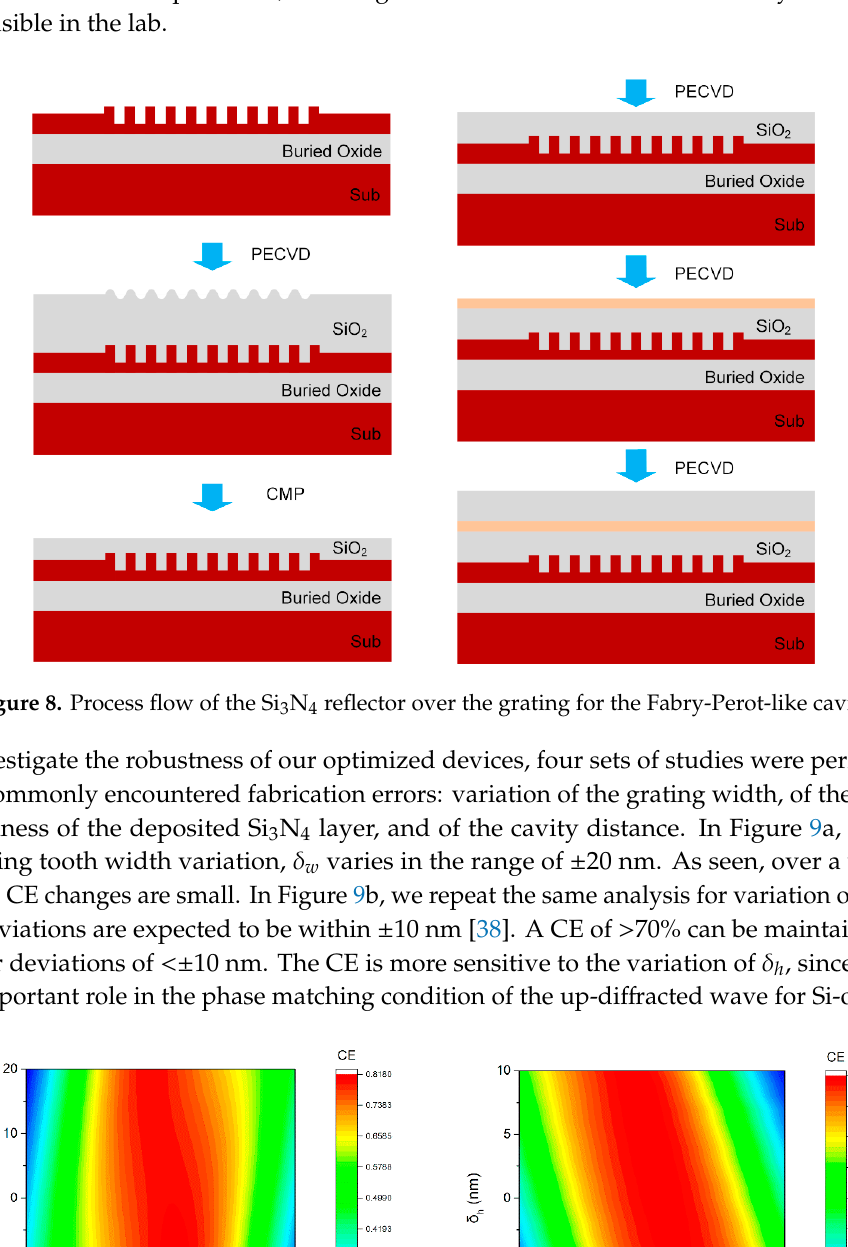
( b ) Figure 10. Fabrication tolerances of the CE: ( a ) Thickness error of the Si 3 N 4 layer. ( b ) Thickness error of the SiO 2 between grating and Si 3 N 4 layer. 4.2. Tolerance of the Polarization Angle The grating coupler proposed here is designed to couple transverse-electric (TE) polarized light into on-chip waveguides, since lots of SOI waveguide devices operate in quasi TE mode. Therefore, the coupling efficiency of our coupler is quite poor for transverse-magnetic (TM) polarized light. As shown in Figure 11, the CE can be maintained above 70% when the deviation of the polarization angle δ p_angle varies from − 20 degree to +20 degree (the polarization angle for TE polarized light is 0 degree), but drops to nearly 1% when the polarization angle reaches − 90 degree or +90 degree, which corresponds to TM polarized light. So far, we have been focusing on improving the performance of the grating coupler, considering TE polarization. The coupling of TM polarized light will be studied in future works.